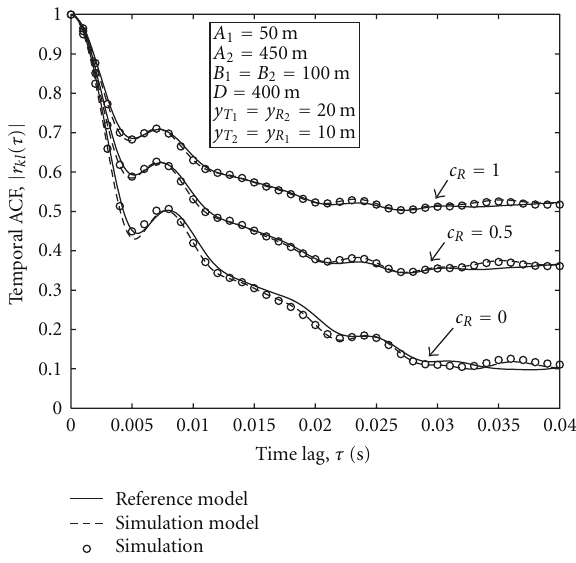
Figure 7: Absolute values of the ACFs | r kl ( τ ) | (reference model) and | (cid:29) r kl ( τ ) | (simulation model) for di ff erent values of the Rice factor c R ∈ { 0,0 . 5,1 } .